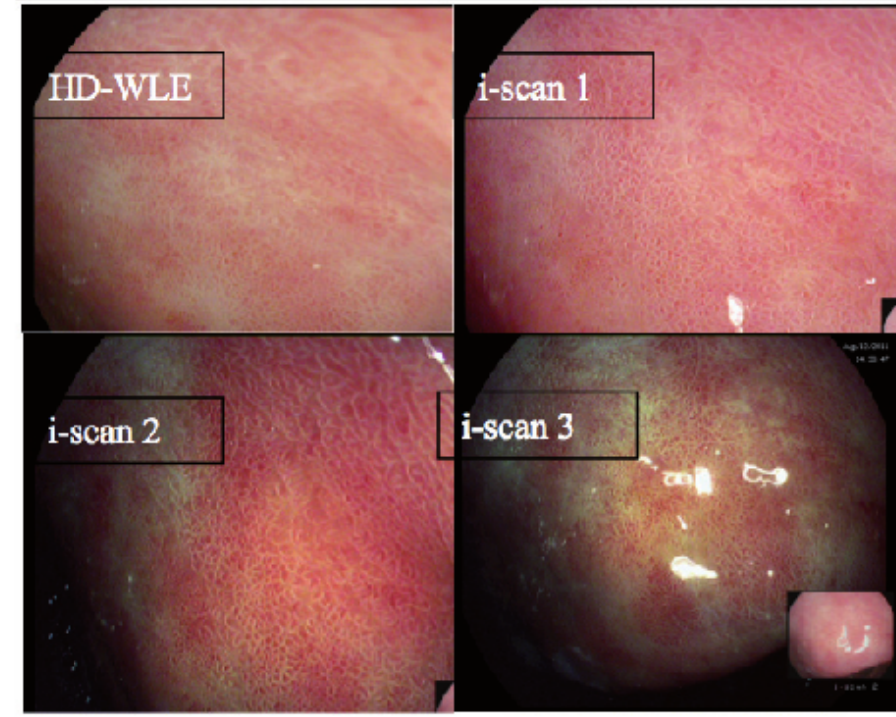
Figure 1. iScan (Pentax) images of Barrett’s esophagus demonstrating the mucosal surface and vasculature